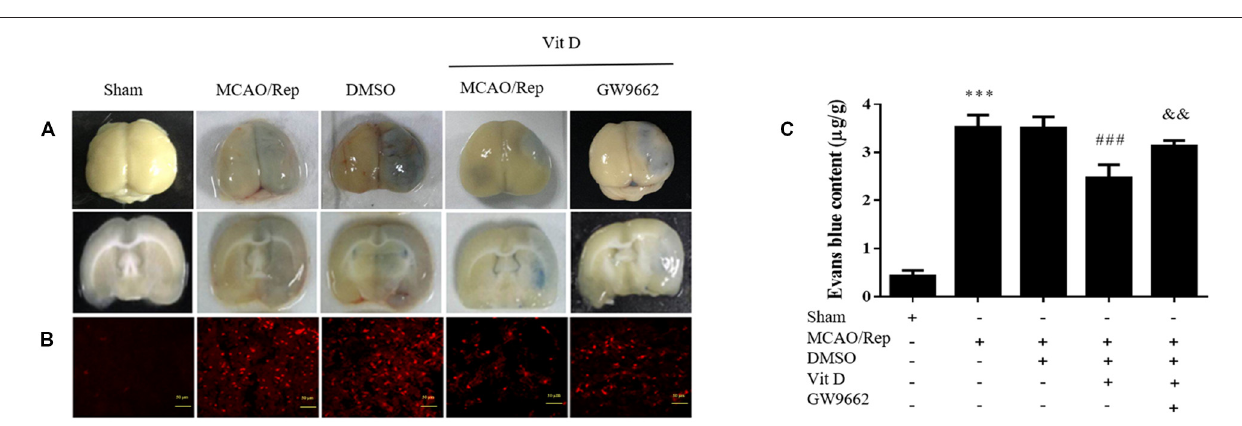
FIGURE 4 | 1, 25-D 3 (Vit D) restores blood-brain barrier (BBB) integrity impaired by ischemic reperfusion. (A) Evans blue (EB)-stained brains 24 h following MCAO/R. (B) EB stained (red) brain sections (original magnification 400 × ). (C) Levels of extravasated EB ( µ g/g of brain tissue). Data are represented as Mean ± SEM, n =